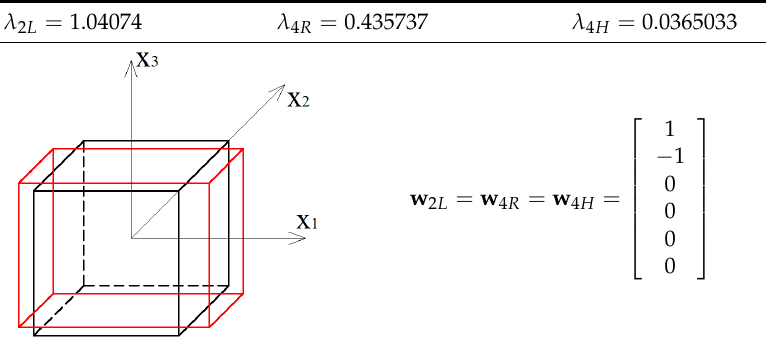
w Table 5. Low shear mode of deformation.